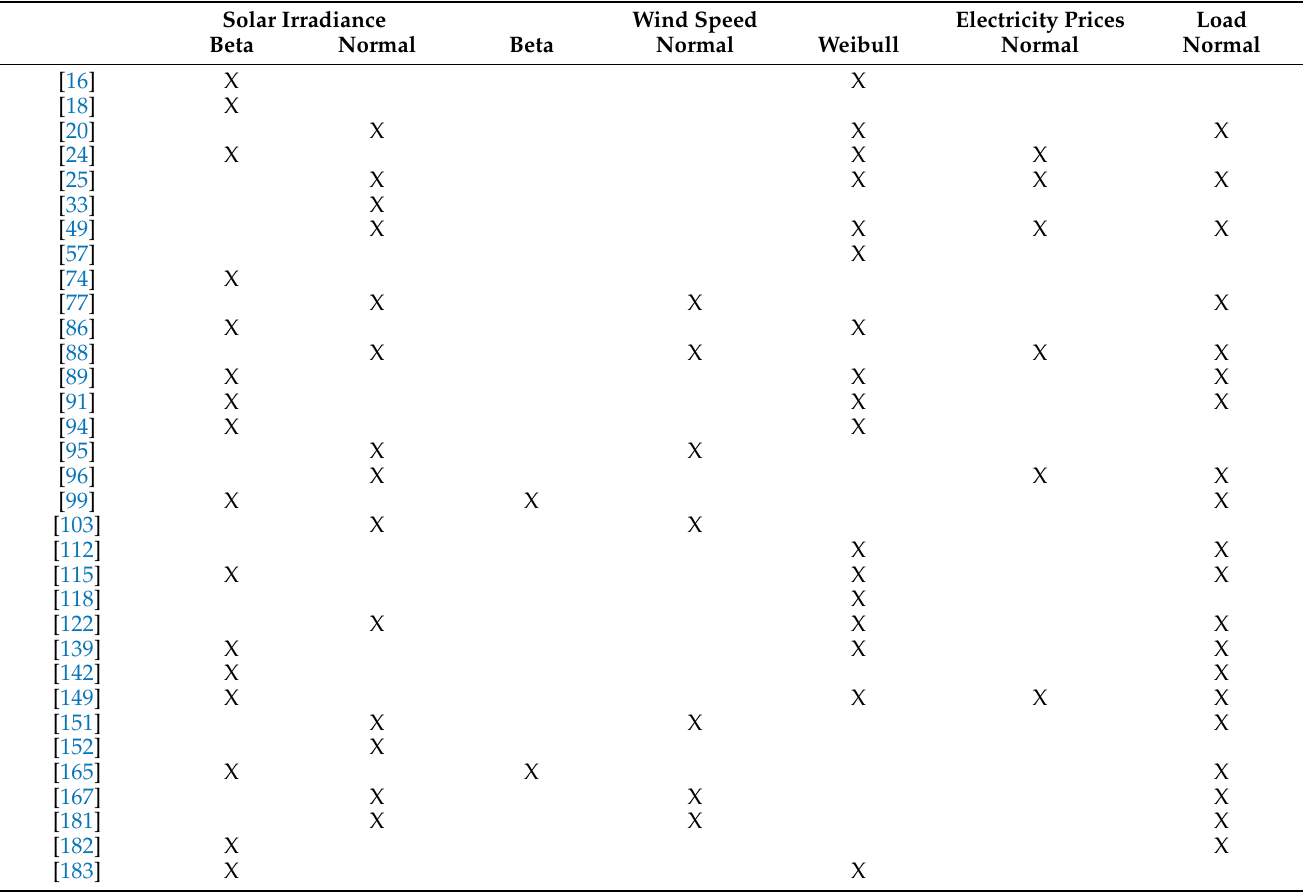
Table 1. Theoretical PDFs employed to characterize solar irradiance, wind speed, electricity prices and